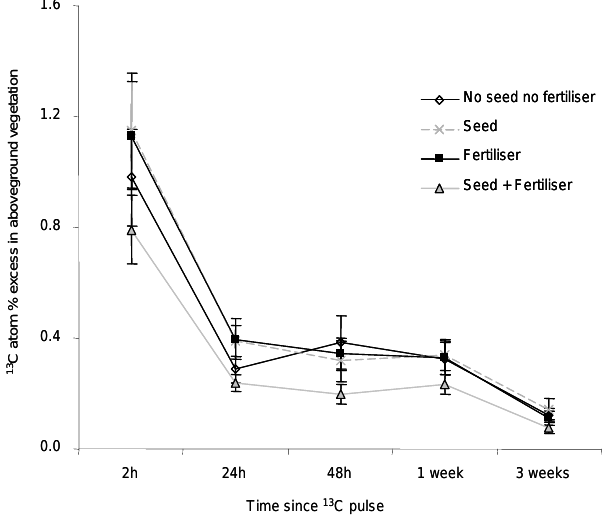
Fig. 3. 13 C atom% excess in leaf tissue from co-occurring species in mixed grassland (two forb F , two grass G , one legume L and a moss species) over a 21-day 13 CO 2 pulse-chase period. Values are means and means sharing the same symbol are significantly differ- ent at the respective time after labelling ( P < 0.05; N = 12).